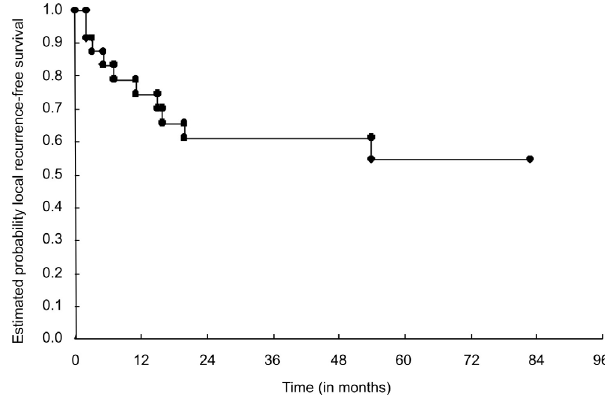
Figure 5 - Curve of local recurrence-free survival in months for the 24 patients with primary osteosarcoma that was non-metastatic at diagnosis